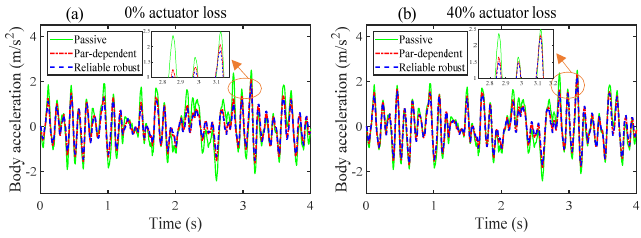
Figure 18. Body acceleration in electric vehicle: ( a ) under 0% actuator loss; ( b ) under 40% actuator loss. Table 2. The RMS of EV dynamic responses with different actuator thrust losses and parameter variation.